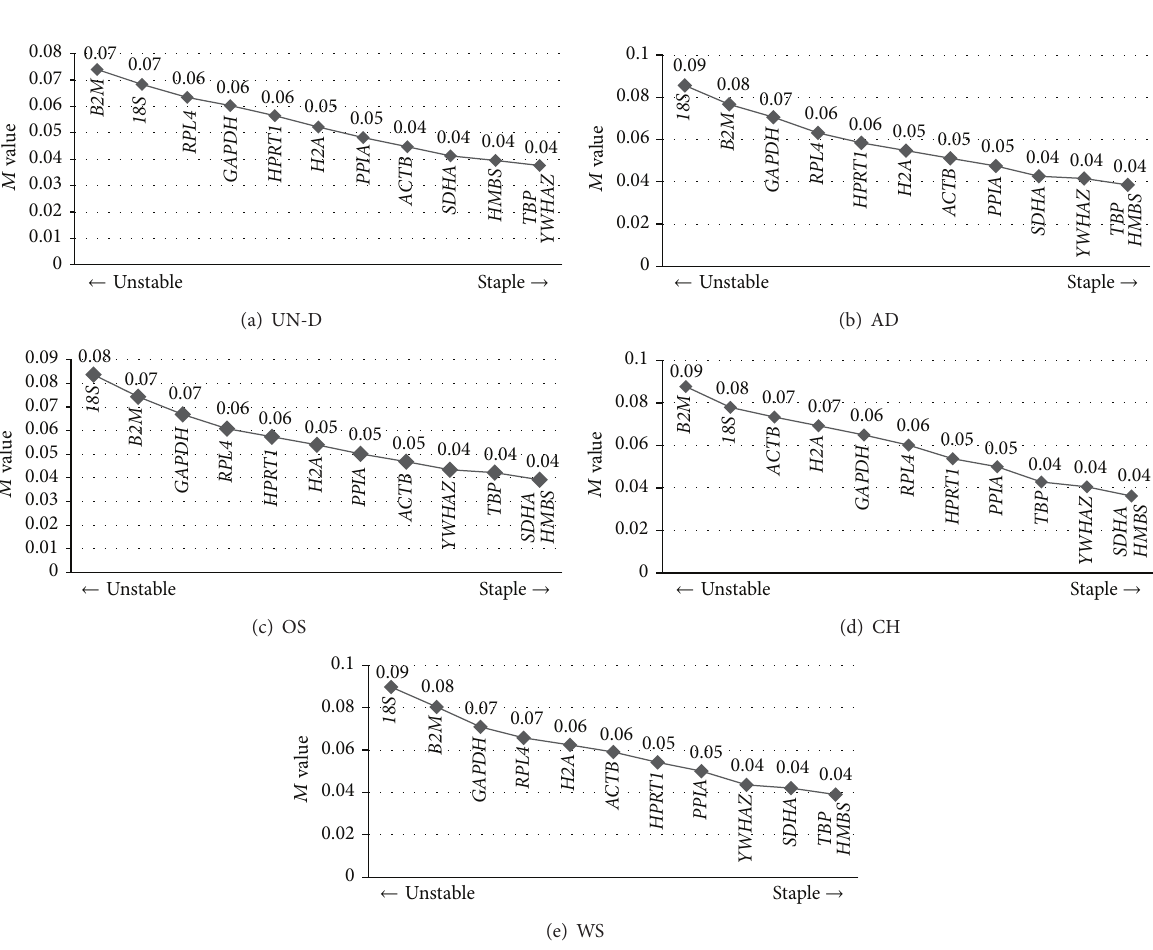
Figure 5: Ranking of stability (M values) in selected reference genes by using geNorm software. M values were analyzed from each Ct value categorizing five groups by geNorm software by calculating the average of pairwise variation between tested twelve reference genes. The left side of graph indicates high M value, which means low stability, and the right side of graph presents high stability with low M value. Each M value is presented above gene symbols. M values of twelve genes for (a) undifferentiated status of BMSCs, AMSCs, and SMSCs and (b–d) differentiated cells into adipocytes, osteocytes, and chondrocytes, respectively. (e) Whole status of